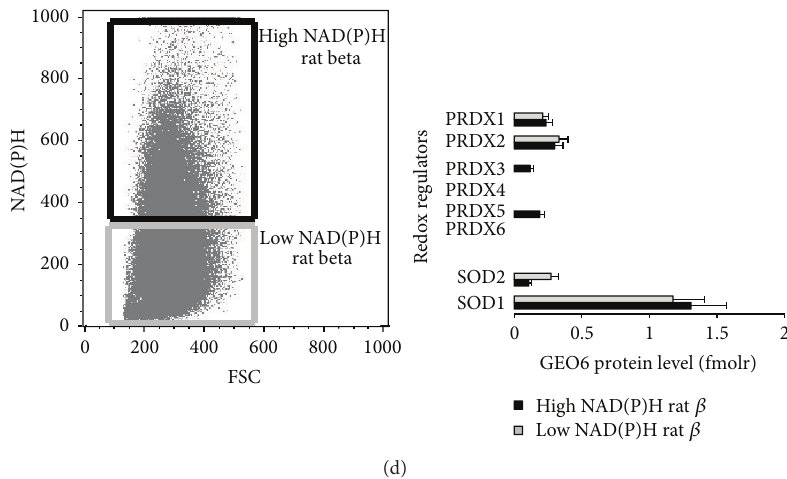
Figure 4: Differences between human and rat beta cells in oxidative stress/heat shock protein expression and response: higher expression of PRDX3 in human beta cells. (a) Overview graph of proteins associated to oxygen radical scavenging and stress-induced heat shock proteins. Data represent mean ± SD geometrically normalized protein amounts in rat beta (black bars, 𝑛 = 3 ), rat alpha (white bars, 𝑛 = 3 ), and human beta cells (gray bars, 𝑛 = 4 ). (b) Human beta cells show a higher resistance to H 2 O 2 -induced cell death in vitro. Human and rat islets were exposed for 2h to the indicated H 2 O 2 -concentrations and cell death was visualized by Hoechst-propidium iodide vital staining. (c) PRDX3 shows an islet-restricted pattern in human but not rat beta pancreas, as shown by immunofluorescence triple staining of human and rat pancreas for PRDX3 (red), insulin (green), and glucagon (white). (d) In rat beta cells, PRDX3 (and PRDX5) expression is restricted to beta cell subsets with higher glucose-NADH responsiveness as shown by quantitative LC-tandem MS. (Bars represent mean ± SD of 𝑛 = 3 experiments, after geometric normalization for 6 reference